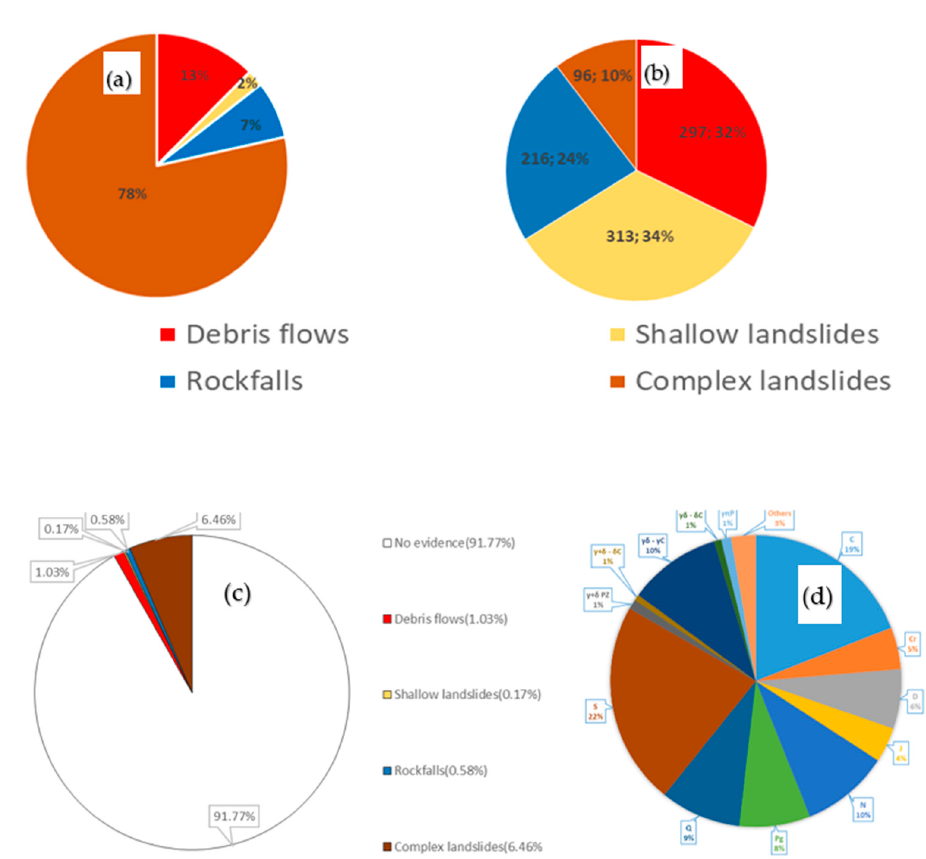
Figure 8. Landslide distribution in the study area: distribution of the surface area of landslides ( a ), distribution of the number of landslides ( b ), percent of surface area affected by landslides concerning the total surface area ( c ), landslides distribution (%) by geological formations ( d ).